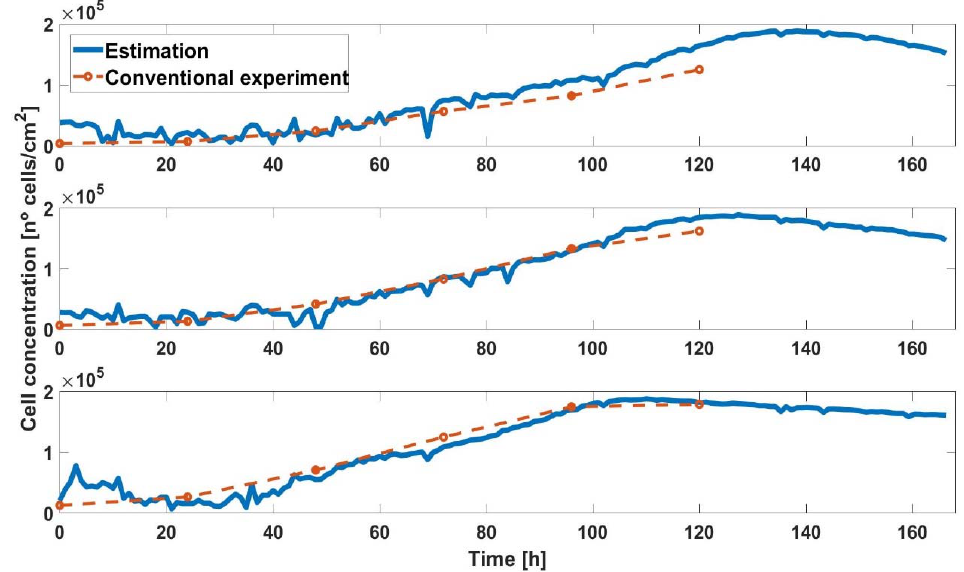
Figure 9. Growth curve with initial number of cells 2500, 5000, and 10,000 (AA8).